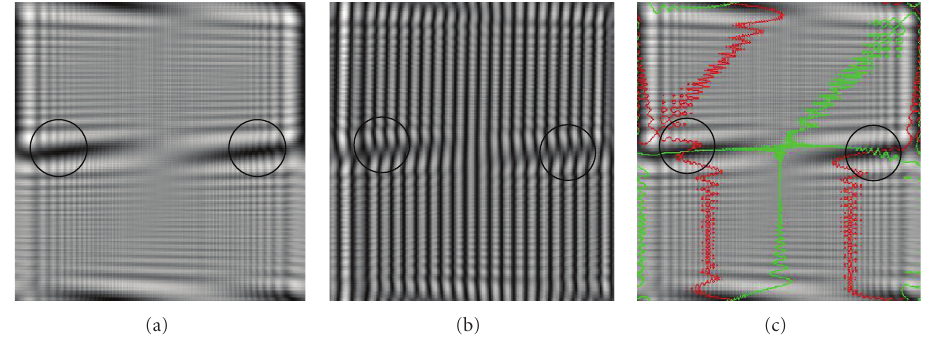
Figure 7: (a) Simulated intensity distribution for one oblique and one linear phase ramp. (b) Simulated interference patterns to check formation of optical vortices. (c) Simulated results for zero crossing of real and imaginary lines one oblique and one linear phase ramp.